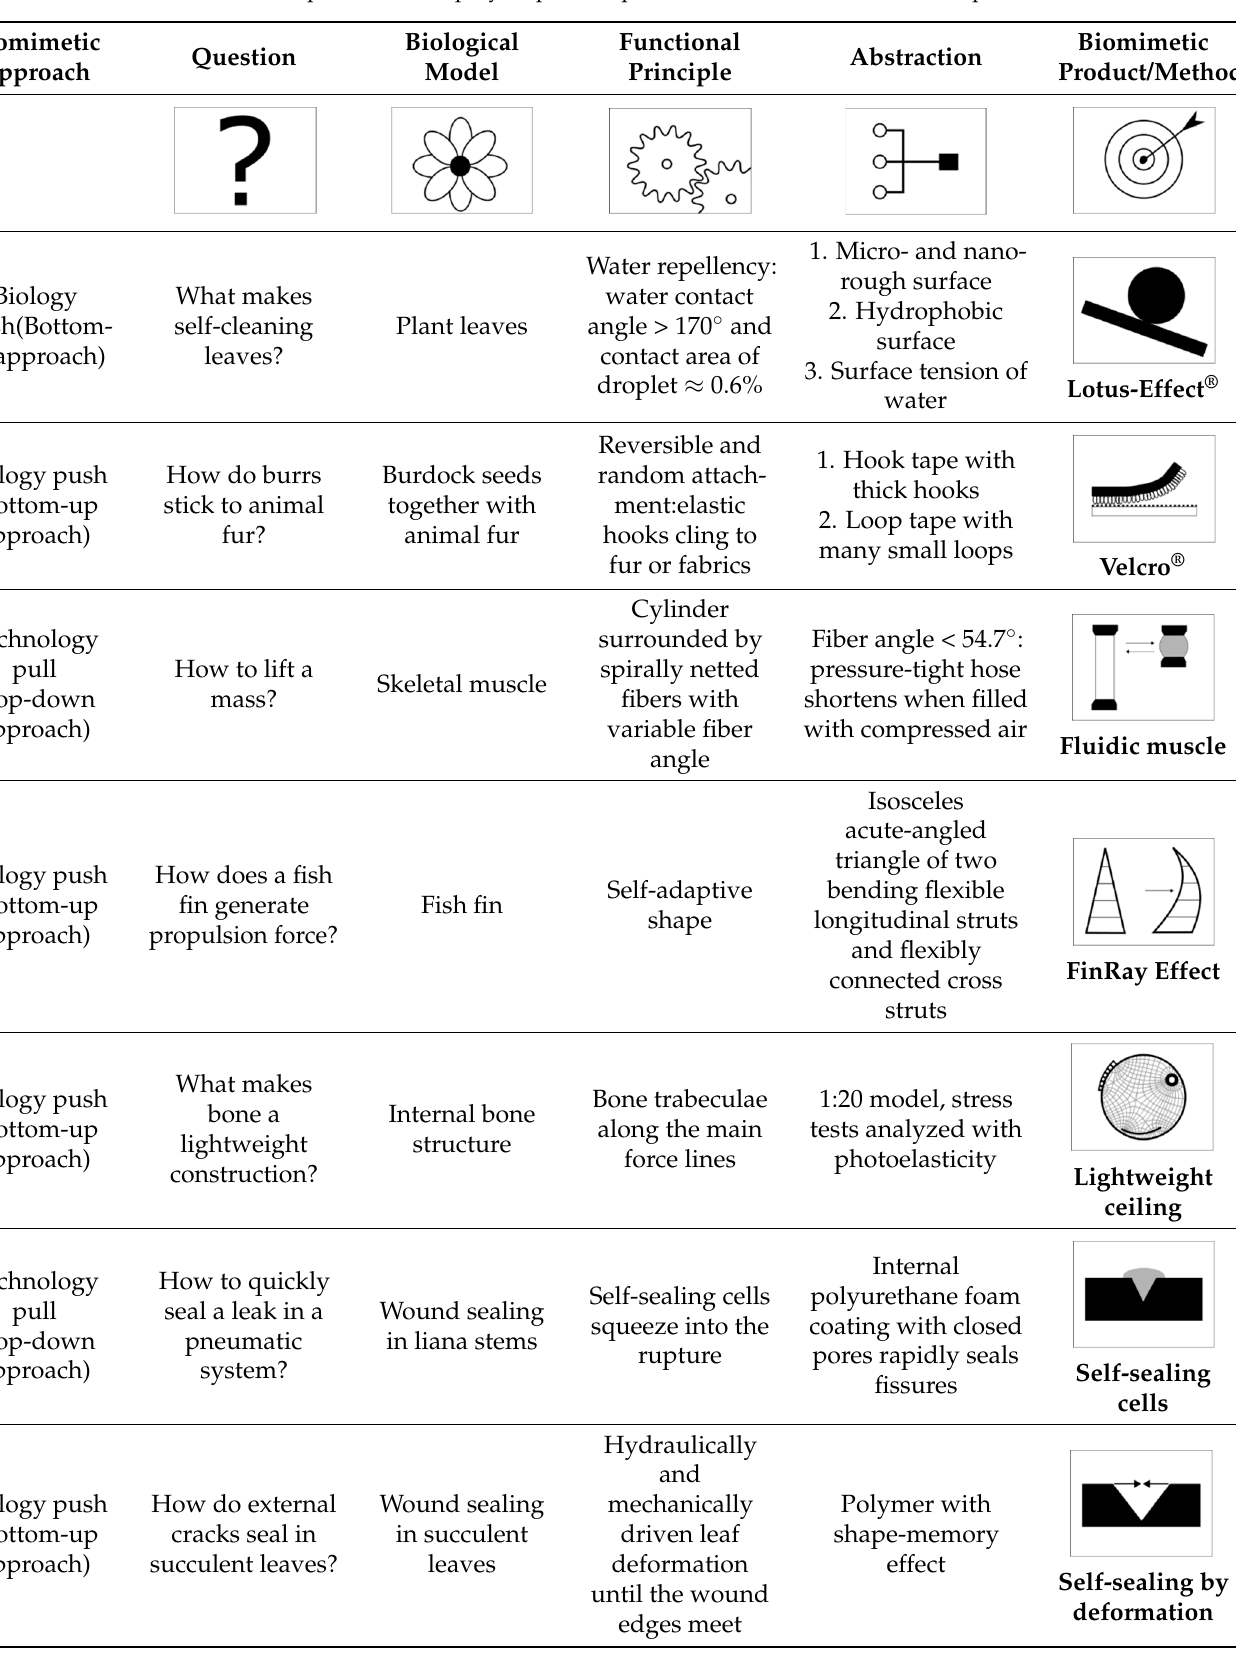
Table 2. Description of the step-by-step development of selected biomimetic examples.